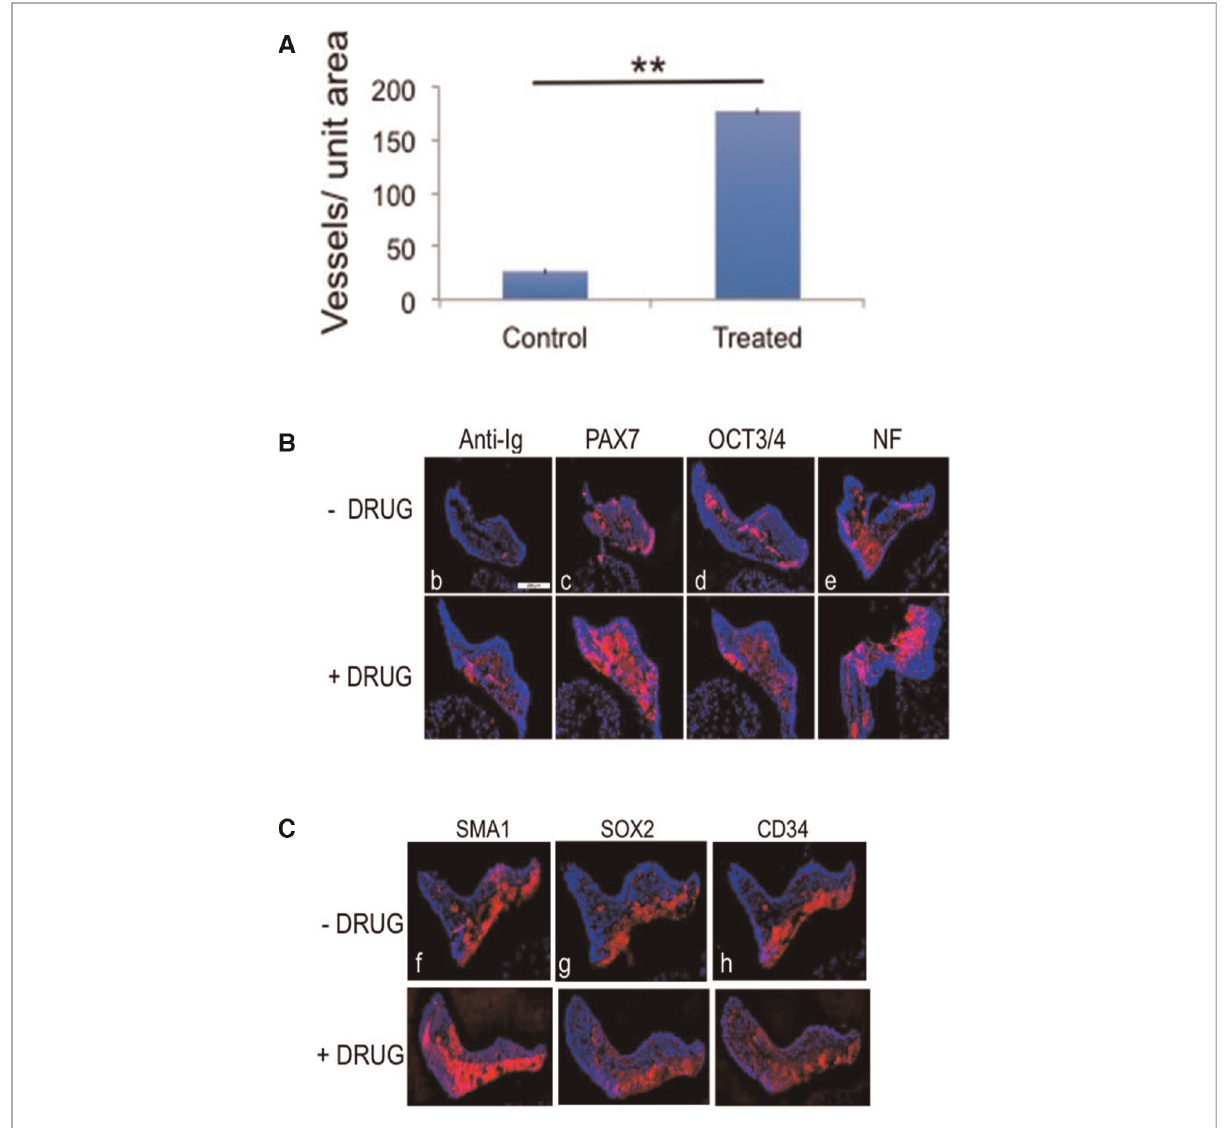
FIGURE 3 Stem cell marker expression in pulp after ligature and drug-treatment. In ( A ), a graph of the level of angiogenesis in the pulp on day 30 ( Figures 2Bb – Cb ) is presented. The level of red in the pulp was determined by determining the number of pixels of red (IHC staining) using Photoshop as compared to the number of pulp area pixels (blue, DAPI) and is shown as a graph of the level of red in ( A ). The Y -axis is the vessel area/pulp area in the control and drug-treated mice; n =4; the error bars are standard errors; the p =0.0027127 and (**) represents p <0.01. Stem cell or de-differentiation marker expression for PAX7, OCT3/4, aSMA (SMA1), SOX2, and CD34 was determined by IHC (red) in the pulp and is seen in (B – H) . The anti-Ig control is lower in drug-untreated than treated samples. The scale bar=200 um for all photomicrographs. The pulp was also examined for expression levels of neuro fi lament (NF), an intermediate nerve fi ber fi lament and marker of innervation ( E ). Quantitative staining using Photoshop CS6 determined the # red pixels over the total number of pixels in the pulp giving % positive staining; (n=4) and percentage of red pixels to total pixels determined. For (B – H) , the no drug control vs. plus drug experimental is seen for ( B ) (0.7% vs. 6%); ( C ) (14% vs. 38%); ( D ) (9% vs. 21%); ( E ) (17.5% vs. 27%); ( F ) (19% vs. 38%); ( G ) (12.5% vs. 13%); and ( H ) (18% vs. 18%). Two markers, SOX2 and CD34, did not show a difference with and without drug on day